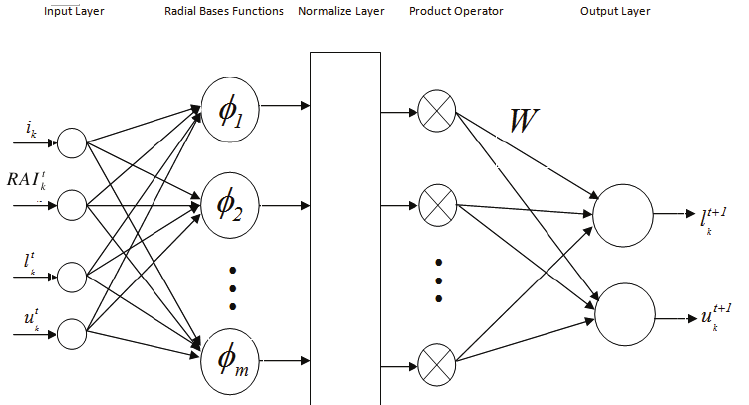
Figure 2. The structure of Norma al Radial Bases Function Neural Network with m neuron for